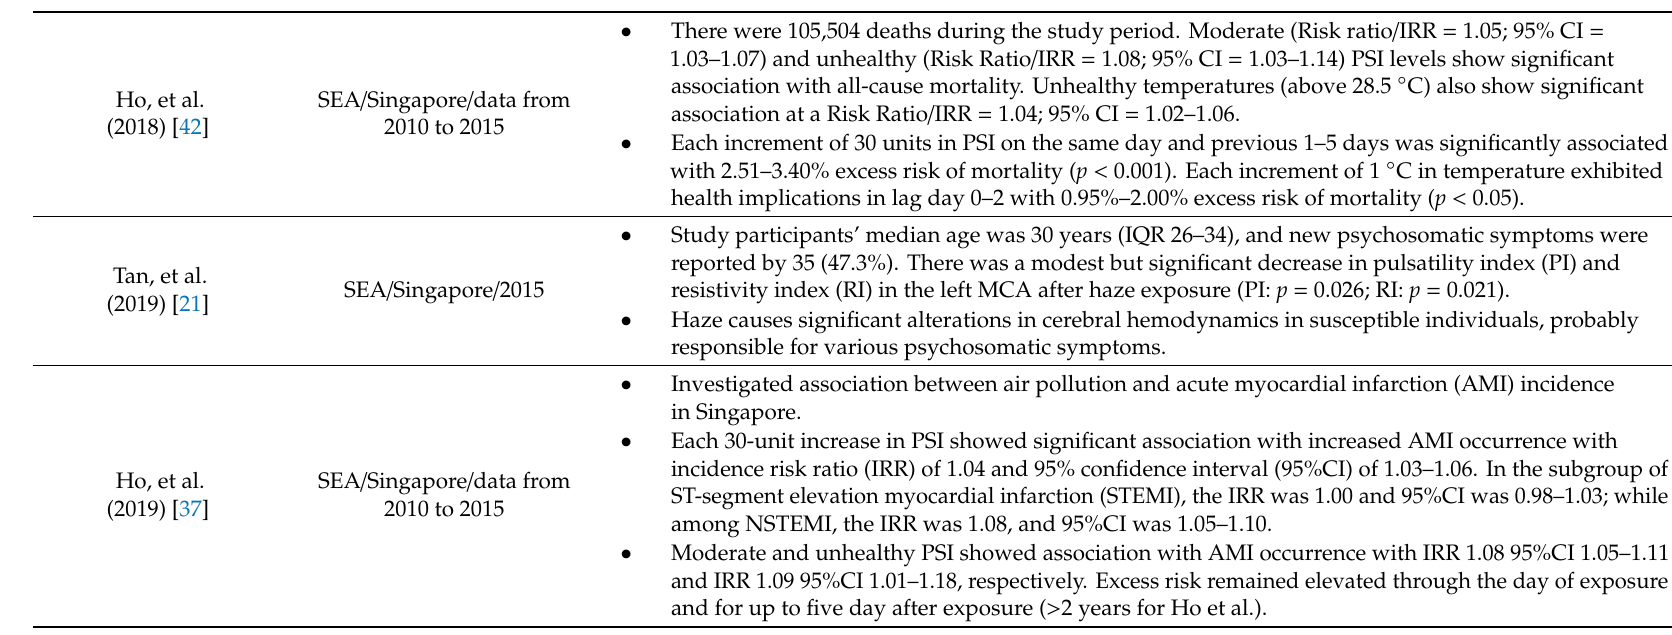
• There were 105,504 deaths during the study period. Moderate (Risk ratio / IRR = 1.05; 95% CI =